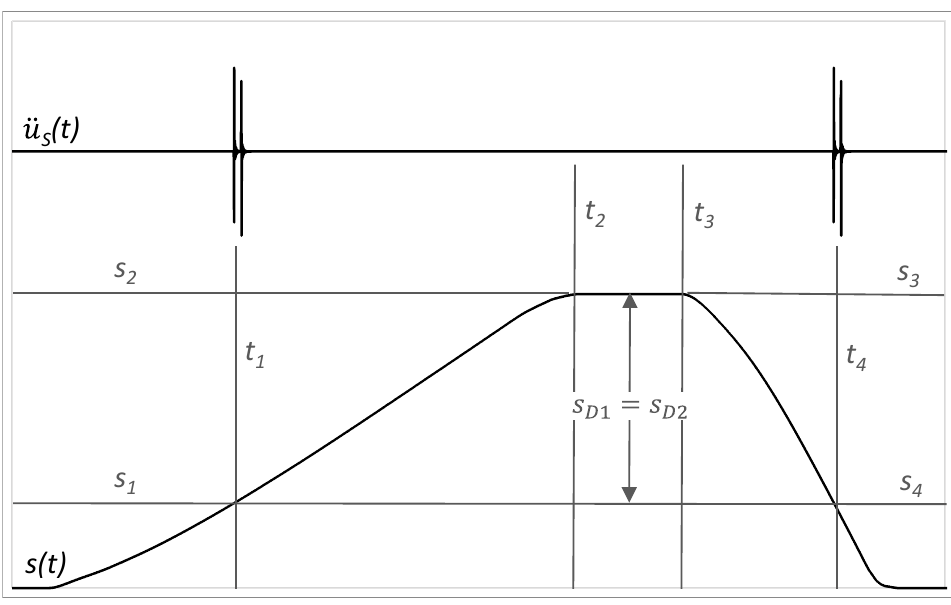
Figure 15. Acceleration amplitudes of vibrations in the context of distance by the damage of guiding profile.